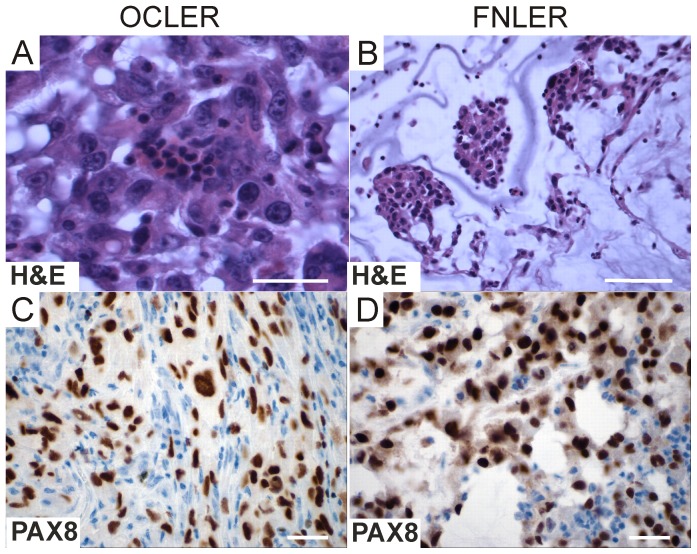
OCLER and FNLER tumor histopathology in immunodeficient nude (Nu/Nu) mice.
A-B, Hematoxylin and eosin (H&E) stains of representative formalin-fixed paraffin-embedded (FFPE) tumor sections from OCLER (A) and FNLER (B) xenografts revealed focal micropapillary structures. The predominant morphology was diffuse sheets of cells with a poorly differentiated tumor architecture (scale bar  =  20 µM). C-D, PAX8 immunoperoxidase stains of representative FFPE tumor sections from OCLER (C) and FNLER (D) xenografts confirmed that xenografts retained their PAX8 expression (scale bar  =  20 µM).